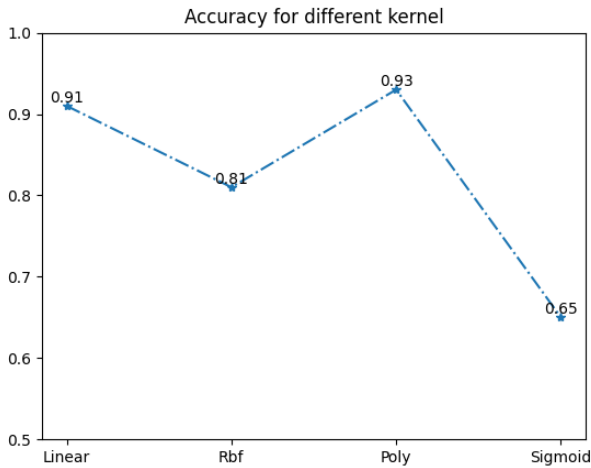
Figure 8. Accuracy for different kernel.